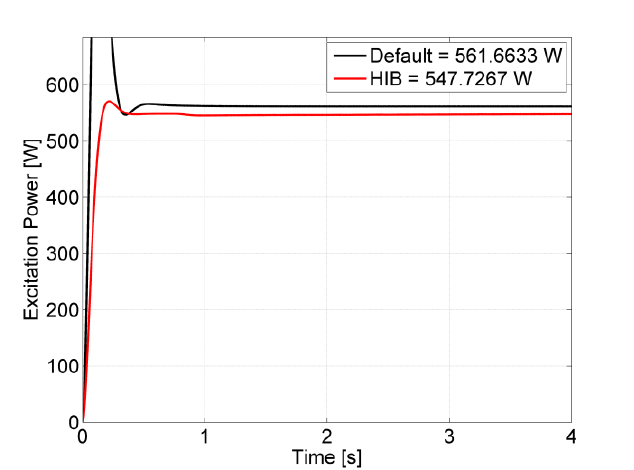
Fig. 14. SRG excitation power after hybrid GA optimization.